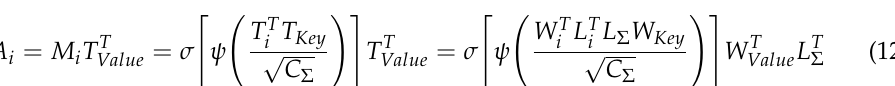
where ψ ( · ) and σ ( · ) denote the instance normalization and the softmax function, respec- tively. We change the original method of the attention operation along the patch-axis in the self-attention mechanism and change the direction to along the channel direction. Instance normalization is also used to normalize each instance’s similarity matrix on the similar mapping, allowing for the gradient to flow smoothly. In the case of N-head focus: